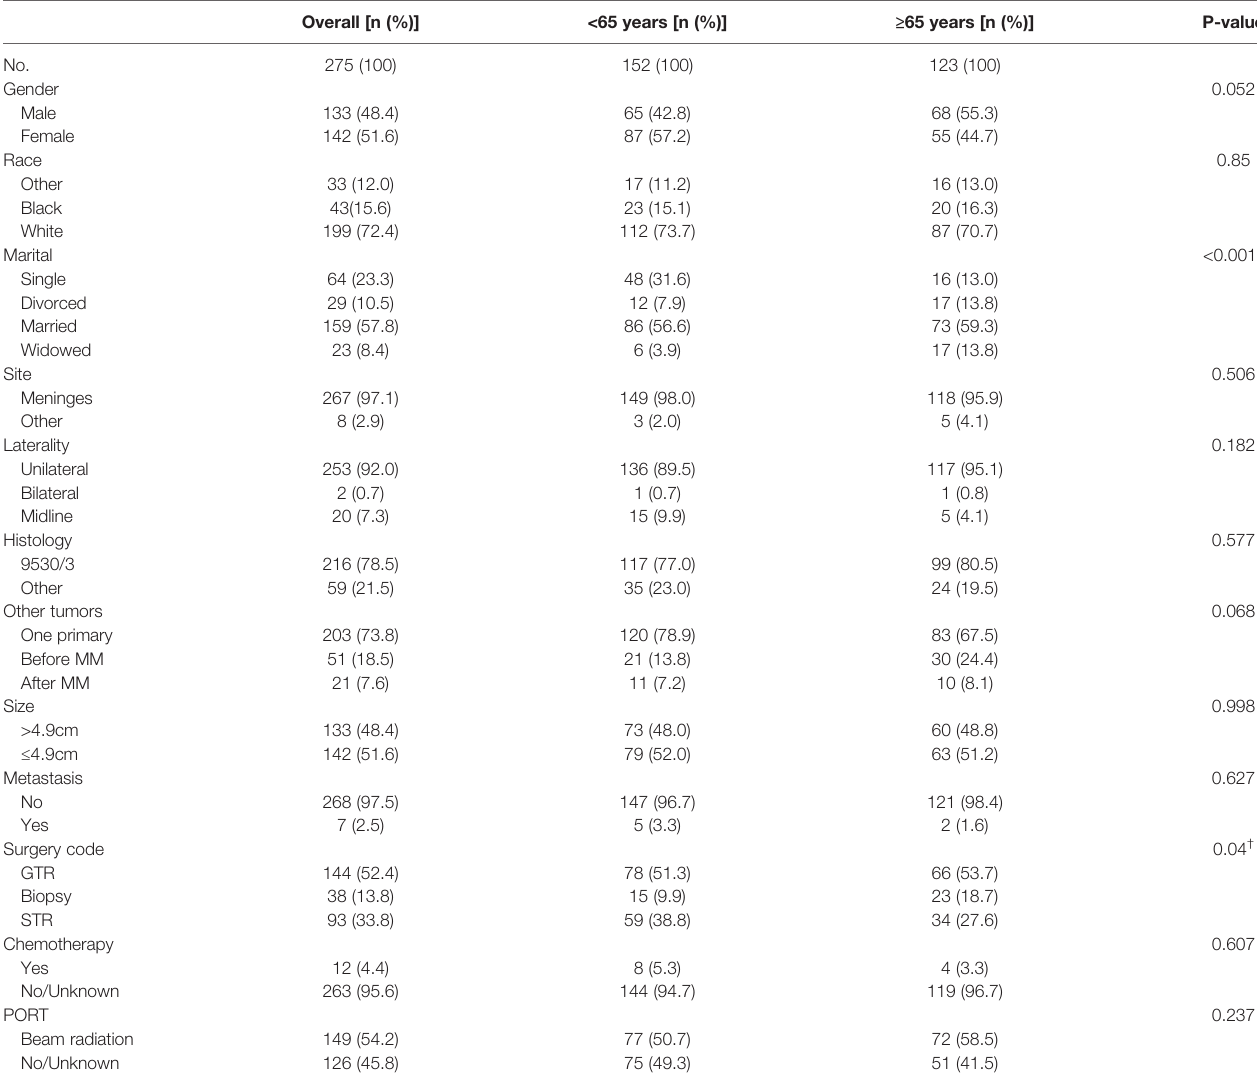
TABLE 1 | Patient demographics, tumor characteristics, and treatment options of 275 patients with MM from 2011 to 2018 in different age